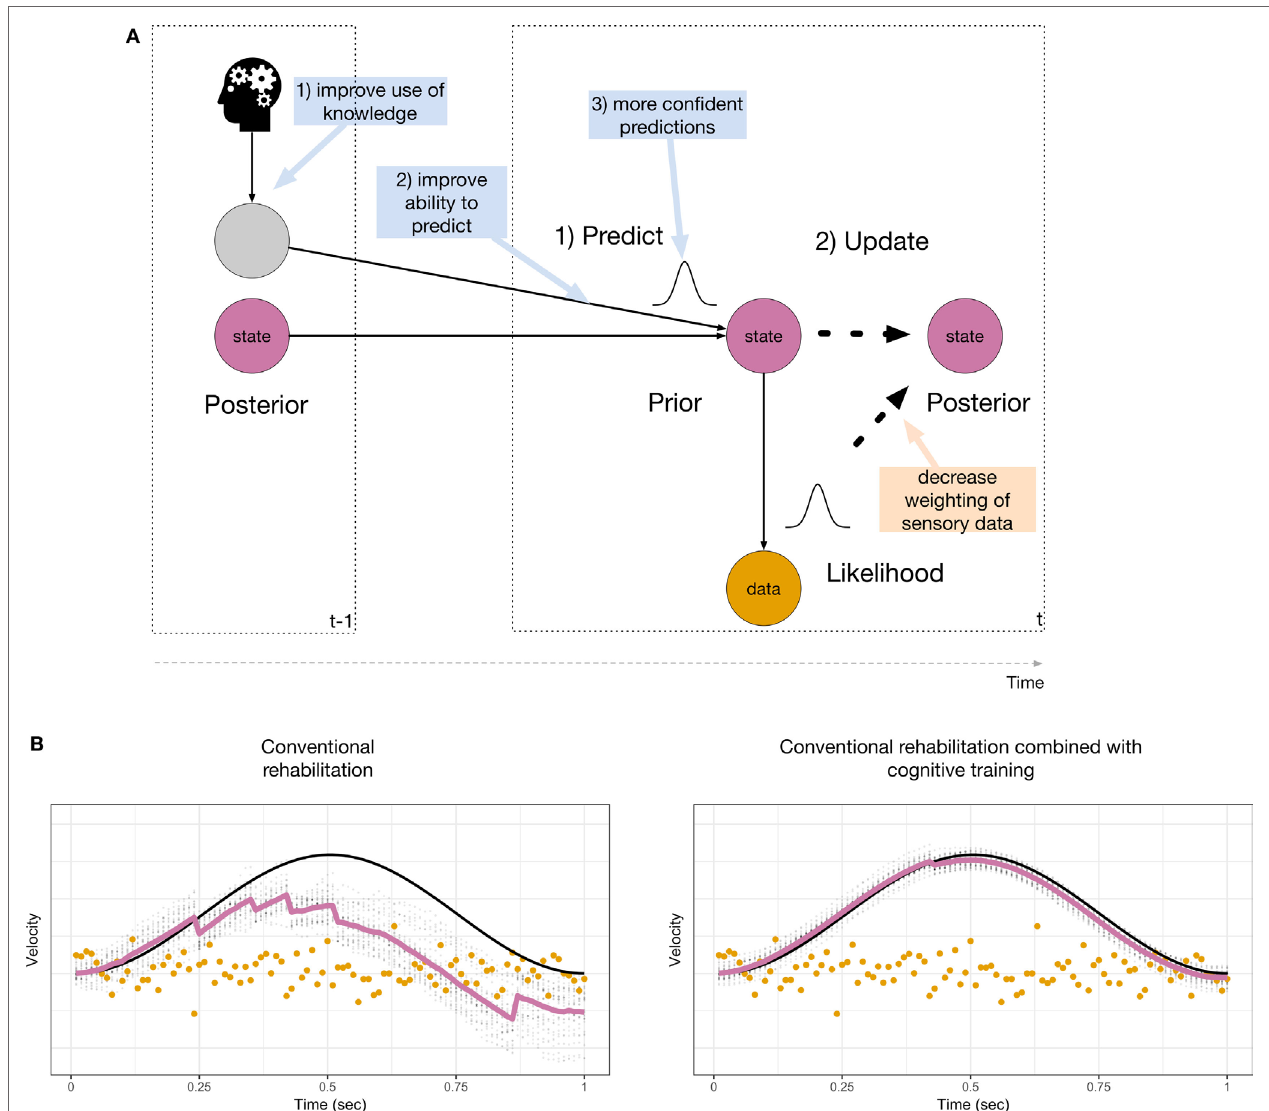
FigUre 2 | (A) Suggested interventions through both conventional rehabilitation (orange box) and cognitive training (blue boxes). Most conventional rehabilitation strategies are targeted at reducing the influence of the sensory data, whereas cognitive training targets the inclusion of prior knowledge for sensory inference. (B) Improvements that may be achieved by conventional rehabilitation (left) and additional cognitive training (right). Inference is improved when abnormal sensory data are ignored (compare with Figure 1D , bottom